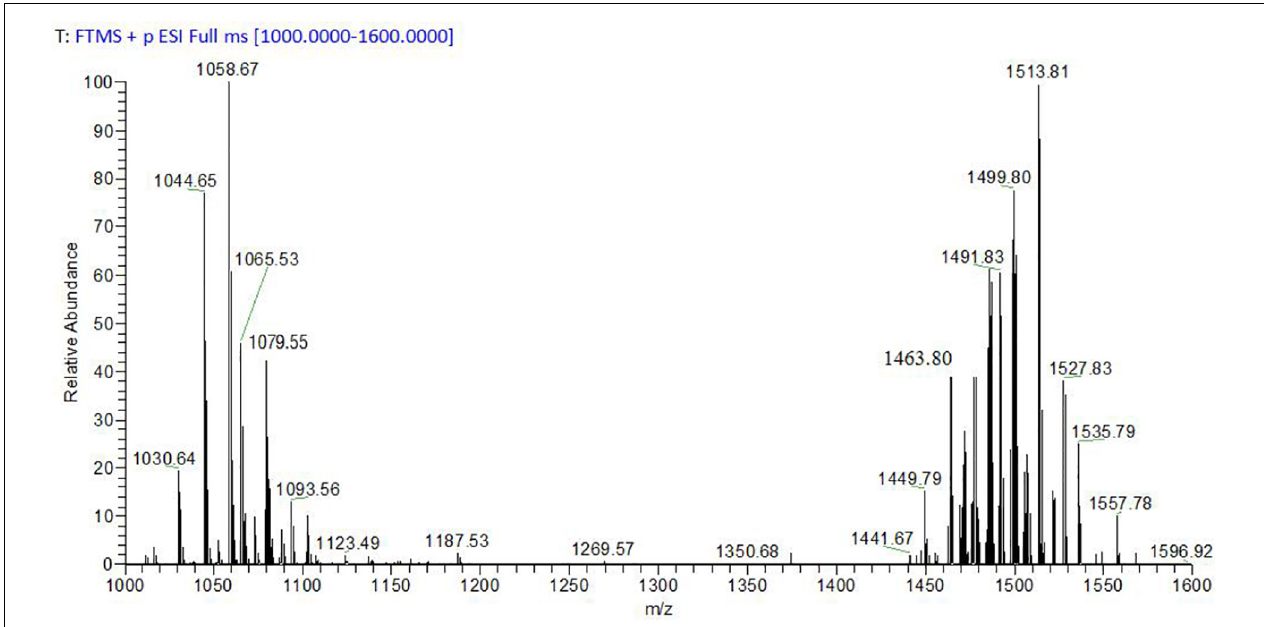
FIGURE 2 | MALDI-TOF-MS detection of B. megaterium WL-3 CLE.